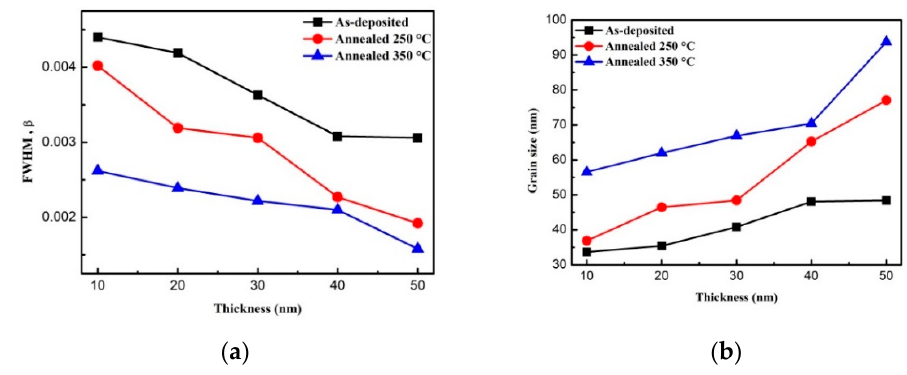
Figure 1. ( a ) FWHM of CoFeW thin films. ( b ) Grain size of CoFeW thin films.